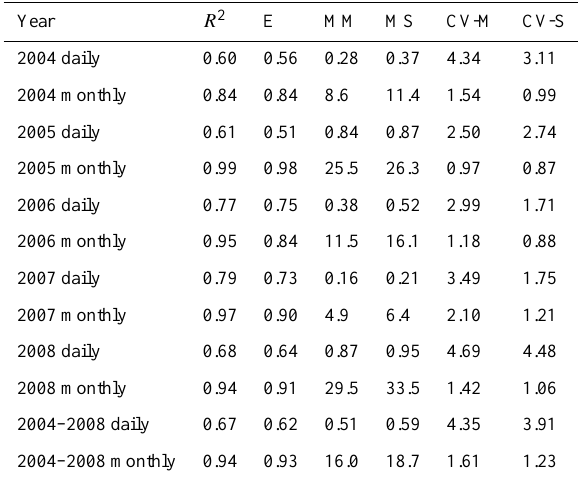
Table 5. Measured and simulated daily and monthly streamflow in 2004–2008 a .